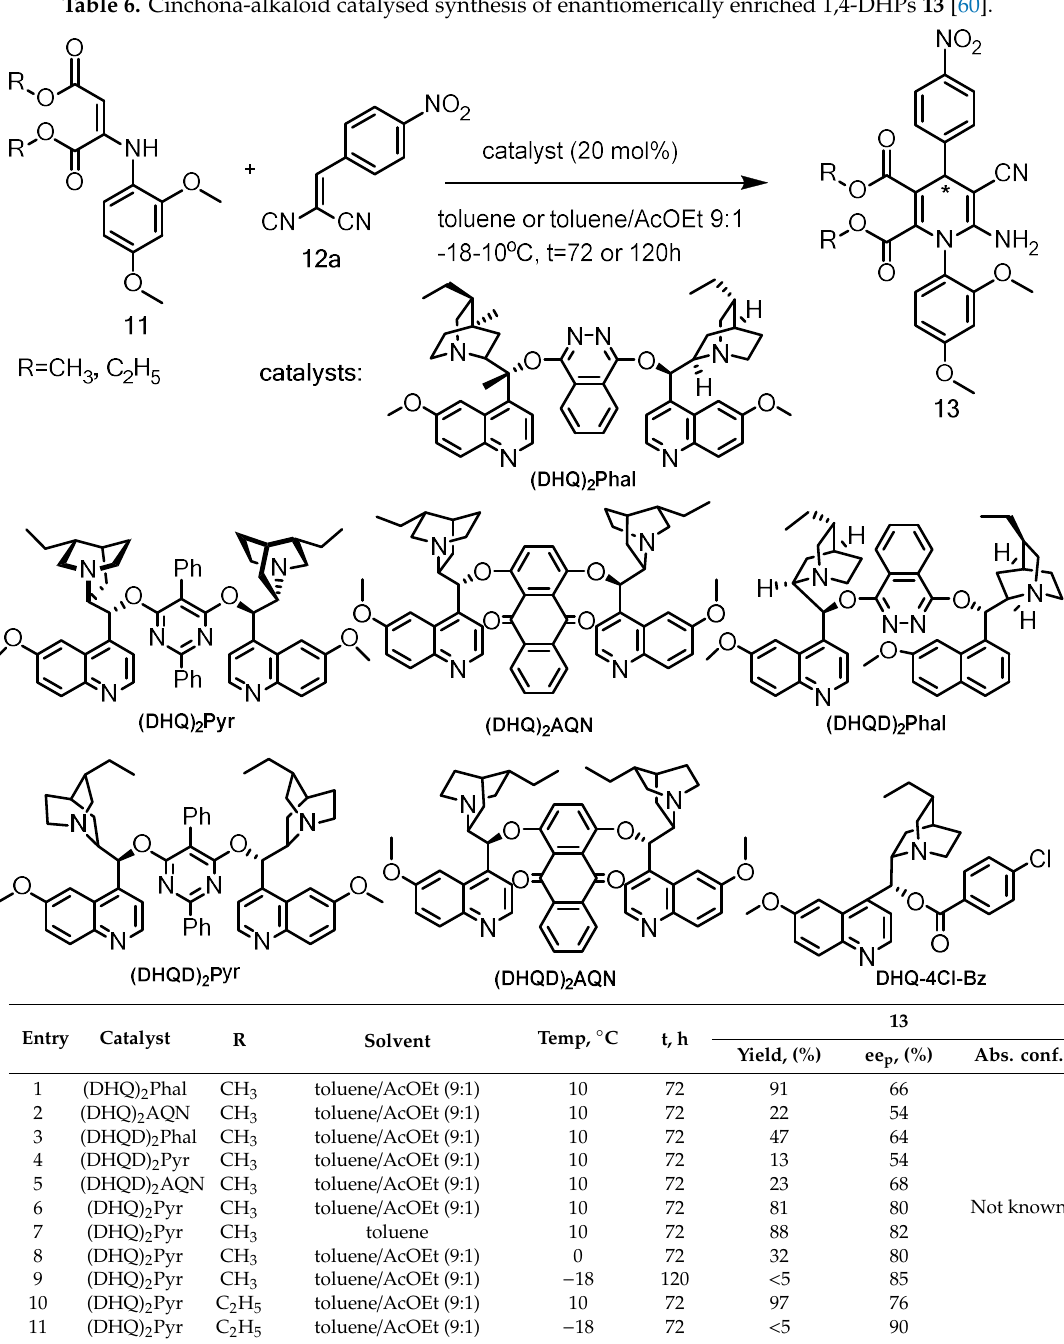
Table 6. Cinchona-alkaloid catalysed synthesis of enantiomerically enriched 1,4-DHPs 13